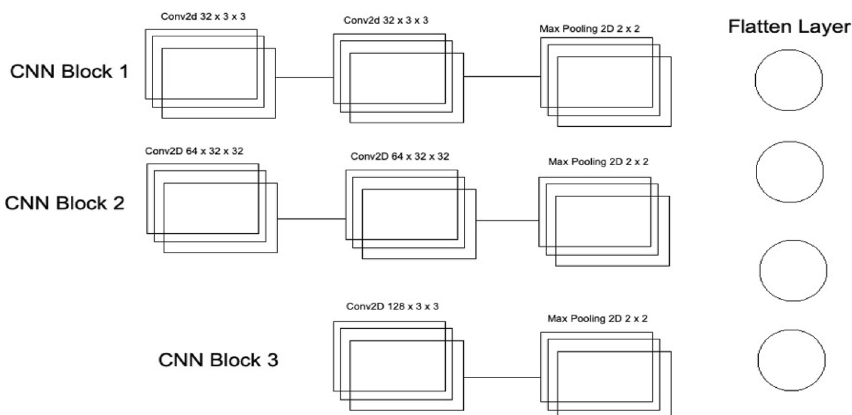
Figure 6. Convolutional neural network one